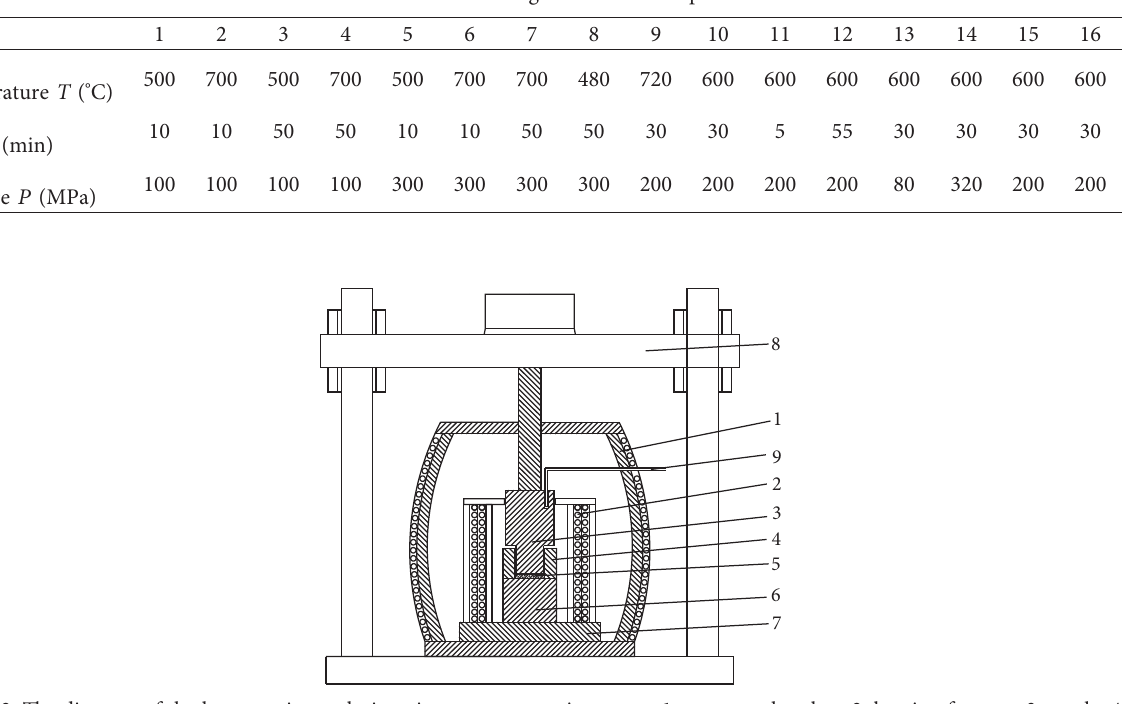
Table 2: The technological data set of specimens.